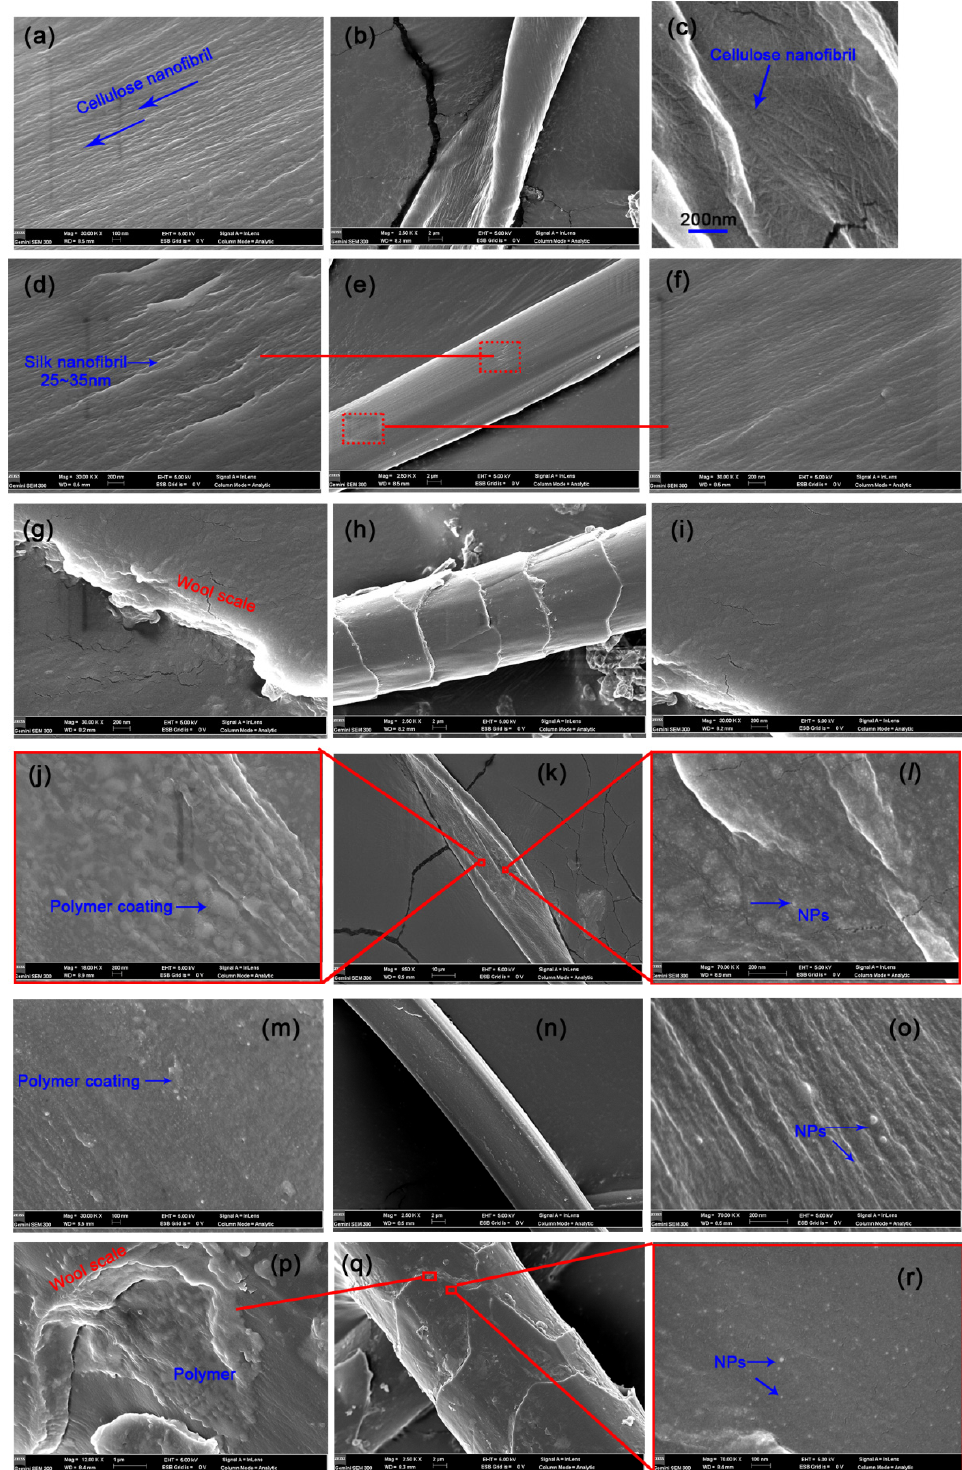
Figure 5. FESEM analysis of ( a – c ) pure cotton, ( d – f ) silk, ( g – i ) and wool and Ag, Au, and Pt NP ternary-coated ( j – l ) cotton, ( m – o ) silk, and ( p – r ) wool (NP content: approximately 5500 mg/g). The amino functional group-driven self-assembly of free HBPAA and HBPAA-capped Ag, Au, and Pt NPs on biomass fibers indicates a remarkable surface chemical transformation, which can be evidenced by XPS (Figure 6) [30]. Typical characteristic peaks that could be assigned to C 1s and O 1s for cotton and C 1s, N 1s, and O 1s for silk and wool were found at approximately 284, 398, and